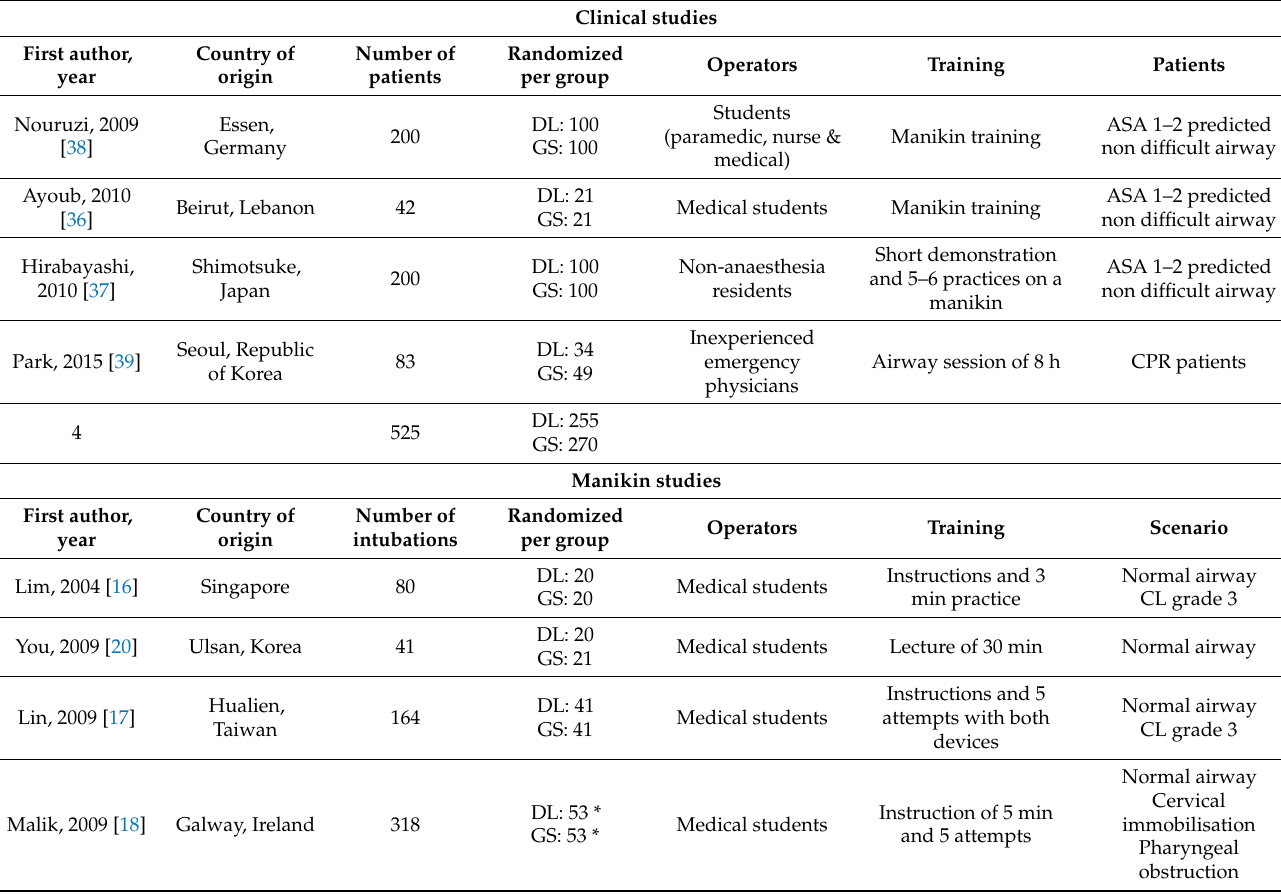
Table 1. Study characteristics of clinical and manikin trials. (*) The number of intubations in this table includes only the first scenario with normal airway. (ASA = American Society of Anesthesi- ologists, CL = Cormack–Lehane, CPR = cardiopulmonary resuscitation, DL = direct laryngoscopy, GS = Glidescope ® videolaryngoscopy, USA = United States of